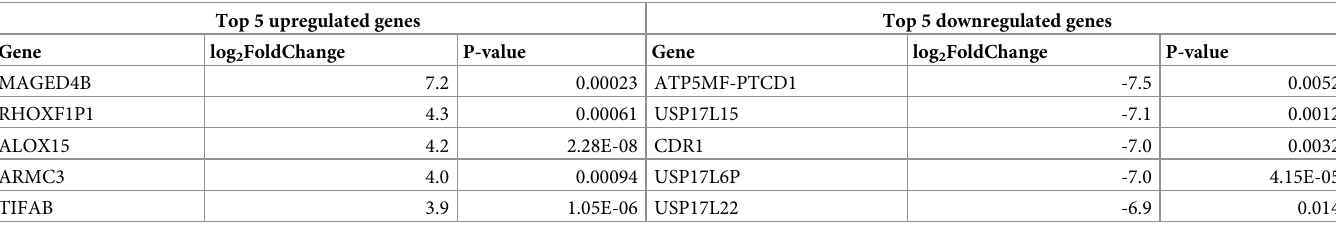
Table 3. Top 10 significantly upregulated and downregulated genes in RHD compared to ARF (based on log 2 FoldChange; p-value < 0.05). Top 5 upregulated